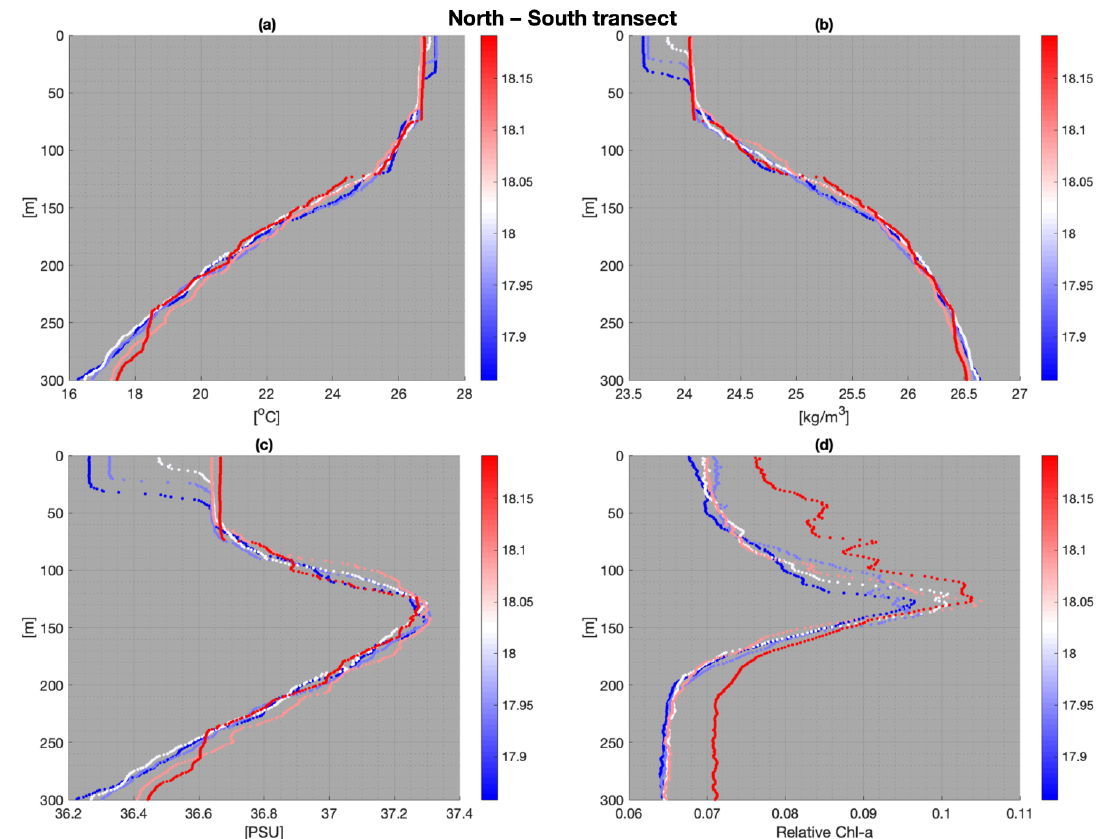
Figure 4. ( a ) Temperature, ( b ) density, ( c ) salinity, and ( d ) relative Chlorophyll-a (Chl-a) profiles for North–South transect stations. Color represents the location of each profile by